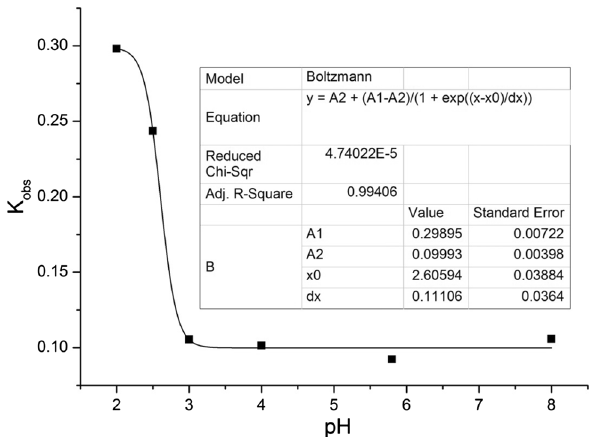
Fig. 3 Relationship between the k ilization condition